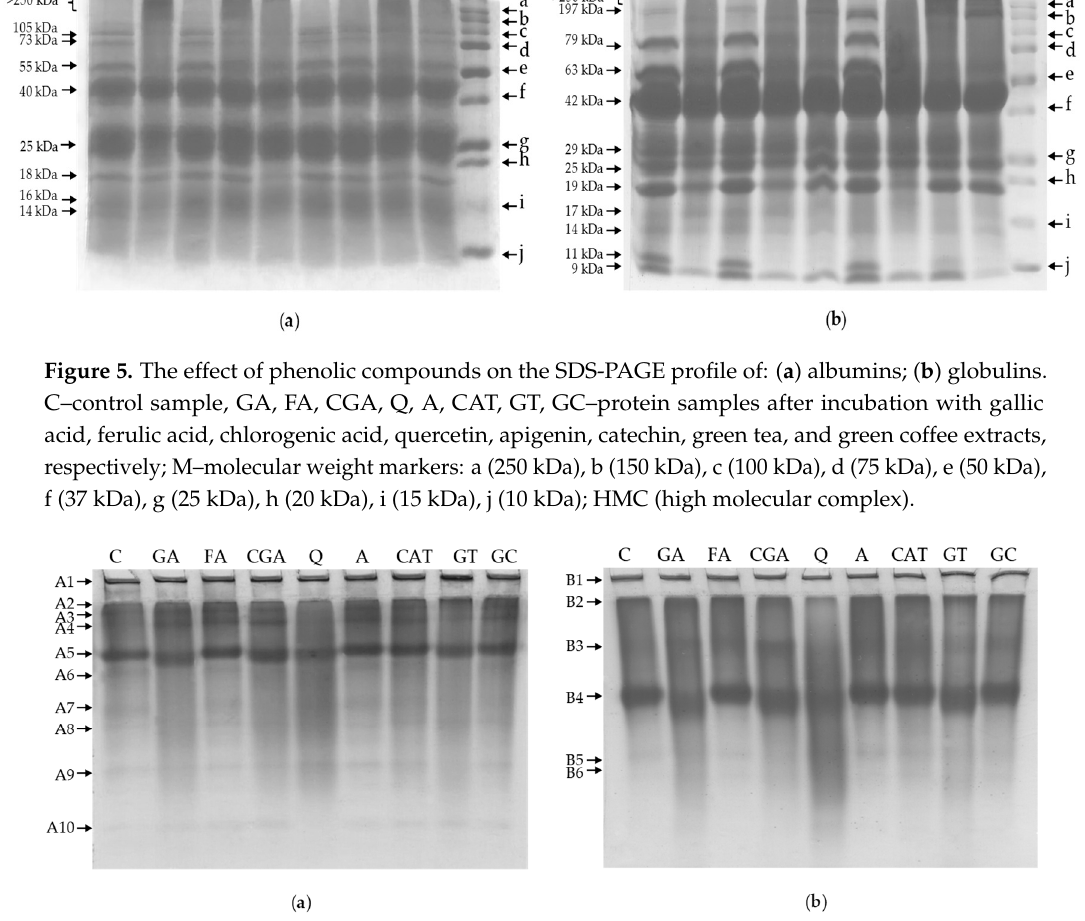
Figure 6. The effect of phenolic compounds on the Native-PAGE profile of: ( a ) albumins; ( b ) globulins. C–control sample, GA, FA, CGA, Q, A, CAT, GT, GC–protein samples after incubation with gallic acid, ferulic acid, chlorogenic acid, quercetin, apigenin, catechin, green tea, and green coffee extracts, respectively; A1–A10: bands detected for albumins, B1–B5: bands detected for globulins.